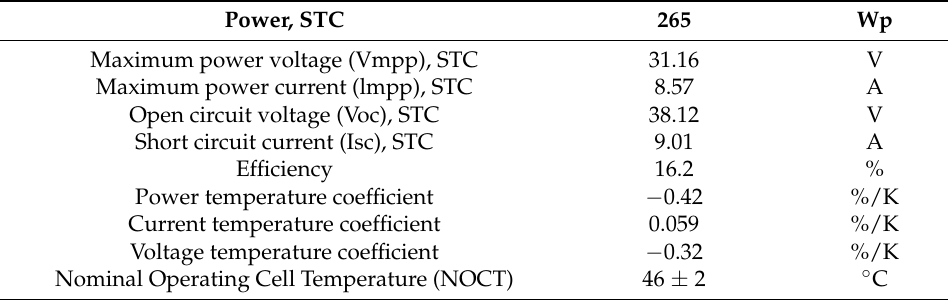
Table 1. Characteristics of the photovoltaic module.